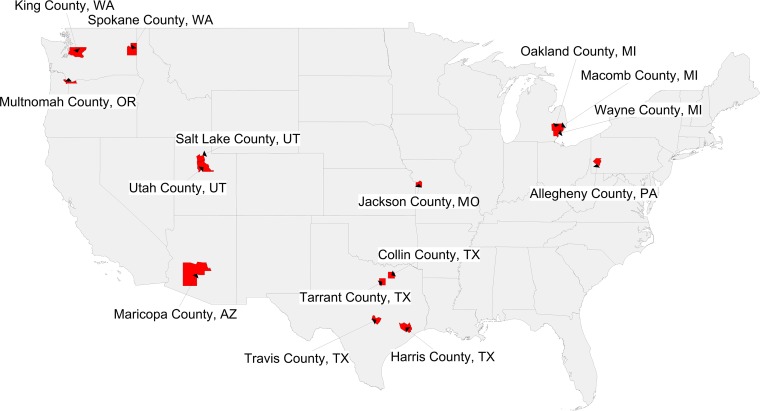
Heat map of counties with >400 kindergarteners with NMEs in 2016 to 2017.NME, nonmedical exemption.